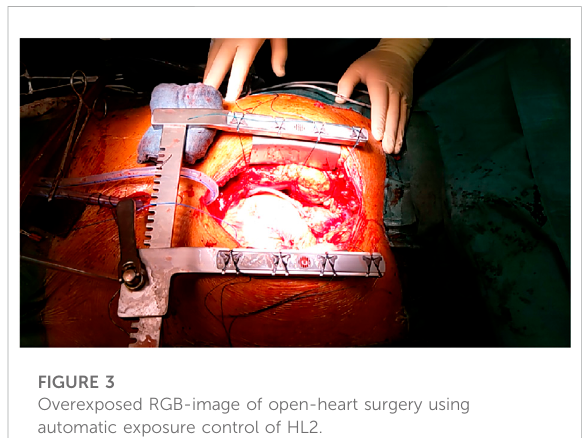
FIGURE 3 Overexposed RGB-image of open-heart surgery using automatic exposure control of HL2.